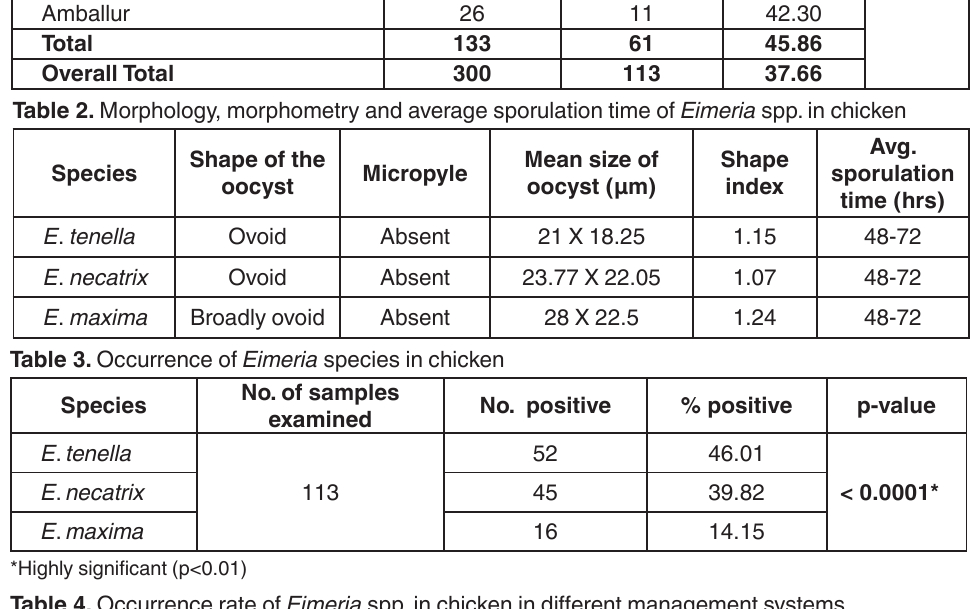
Table 4. Occurrence rate of Eimeria spp. in chicken in different management systems Management